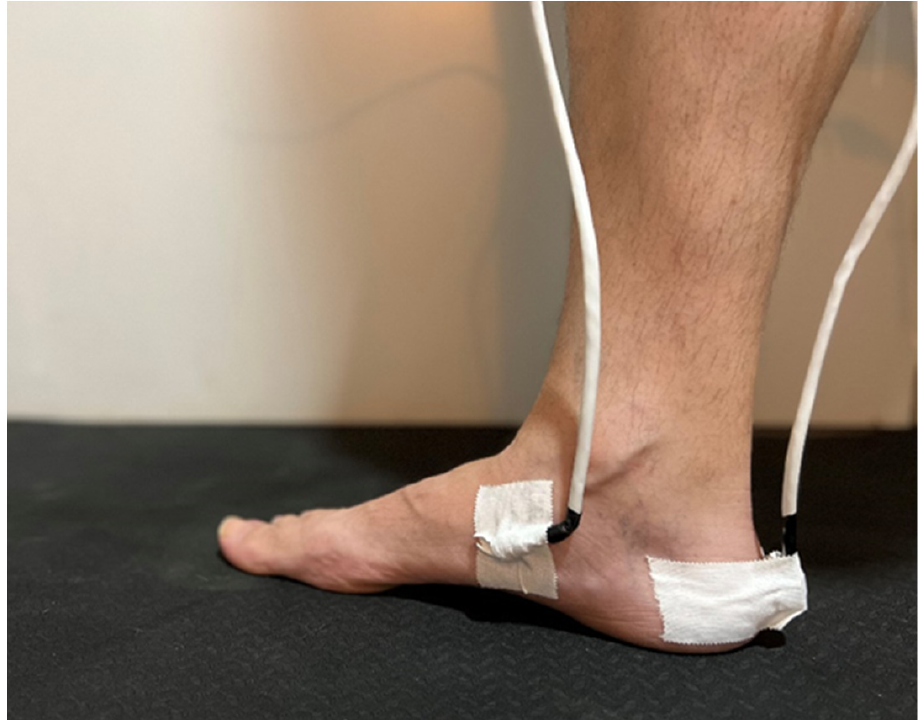
Figure 2. Sensor one was placed on the posterior part of the calcaneus bone, and sensor two was placed on the medial navicular tubercle.